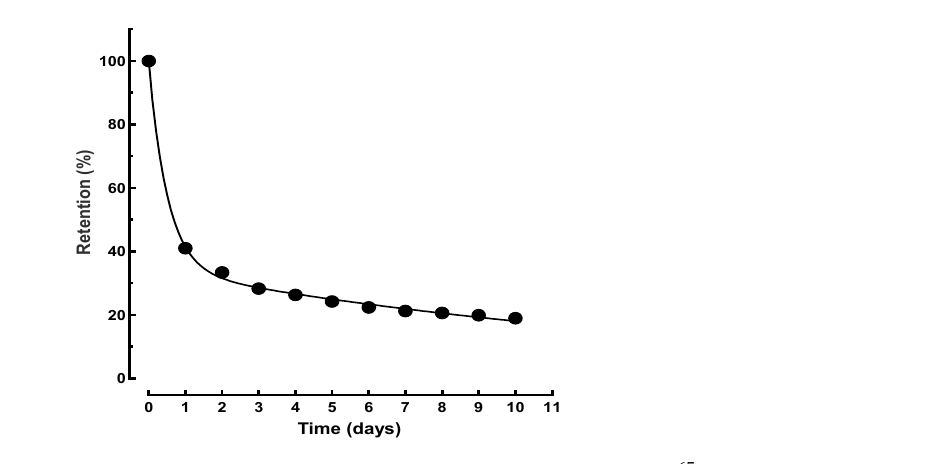
Figure 8. Pharmacokinetics mathematical modeling of the 65 Zn decorporation following rapid intervention with higher dose of Zn-DTPA (i.e., 5 mg/0.25 mL/100g b.w.).